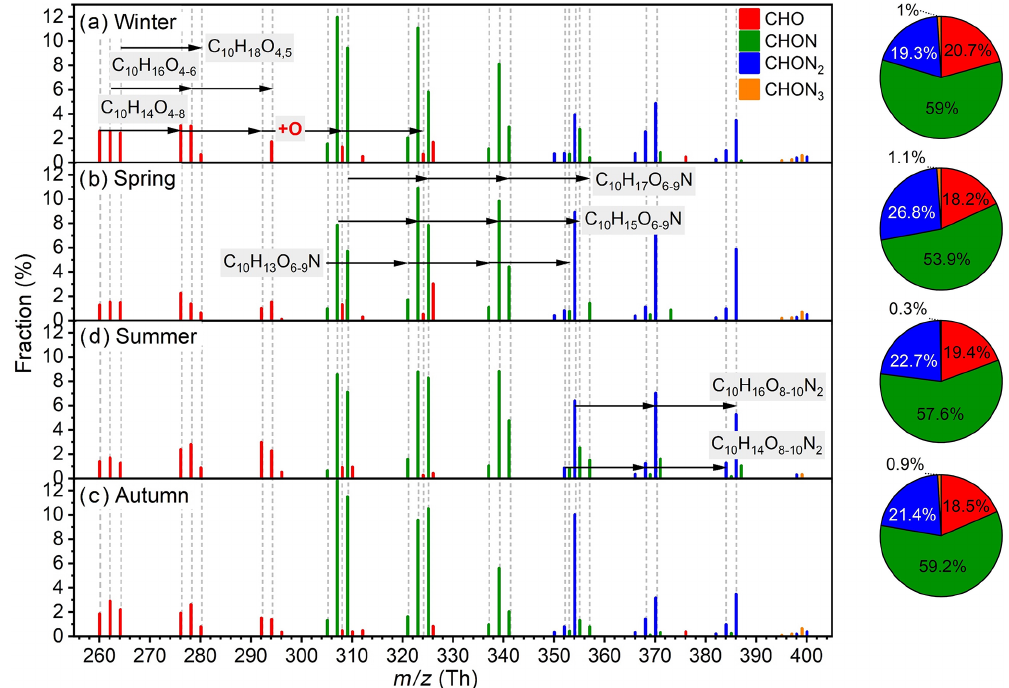
Figure 7. Fractional profiles of each MT OOM molecule in (a) winter, (b) spring, (c) summer, and (d) autumn. The mass-to-charge ra- tio ( m/z ) denotes OOM clustered with NO − or as deprotonated ones. The fraction of each compound is calculated as the ratio of its 3 concentration to the total concentration of MT OOMs. The red, green, blue, and orange bars are for CHO, CHON, CHON 2 , and CHON 3 OOMs,